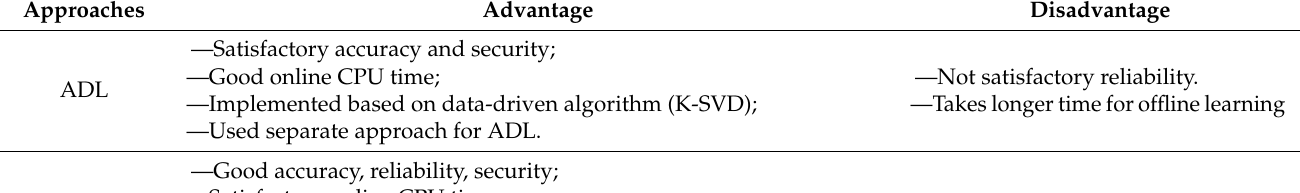
Table 6. Advantages and disadvantages of fixed and adaptive dictionary learning for TSA. Approaches